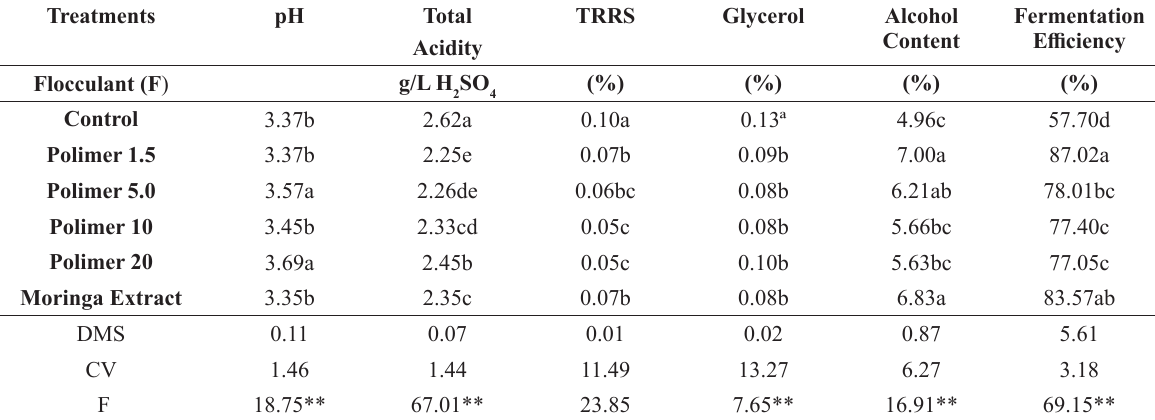
ORGANIC JUICE TREATMENT FOR ETHANOL PRODUCTION WITH Moringa oleifera LAMARCK